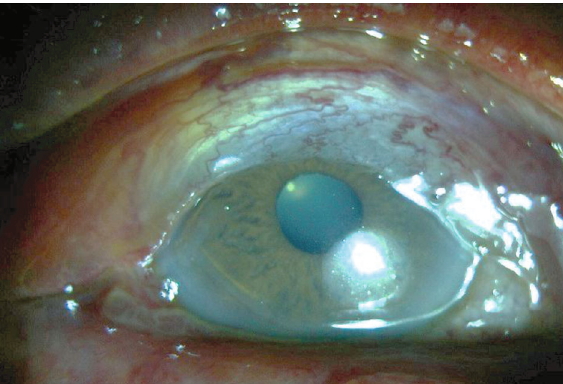
Figure 2: Conjunctival congestion with tortuous vessels in the left eye.